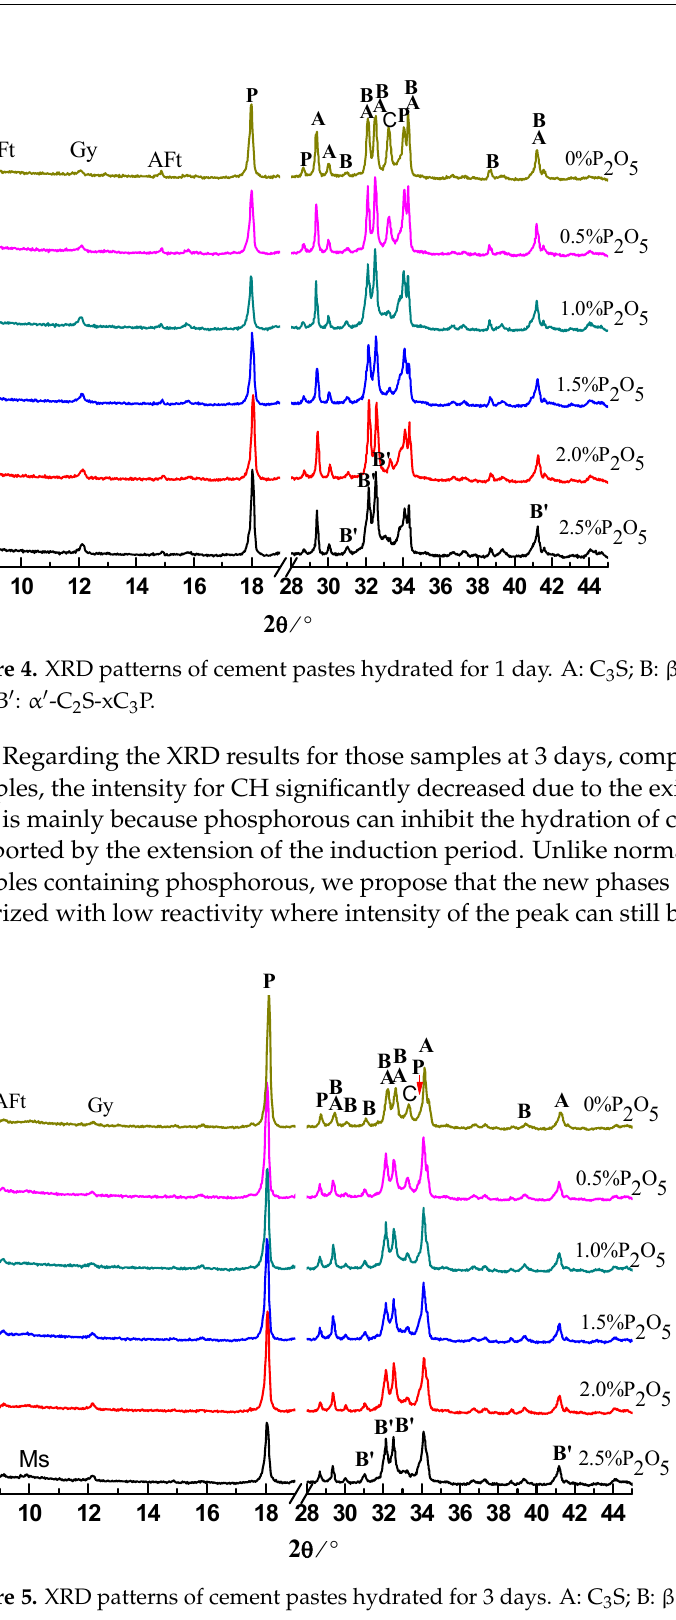
Figure 5. XRD patterns of cement pastes hydrated for 3 days. A: C 3 S; B: β -C 2 S; P: CH; Ms: AFm; B ′ : α′ -C 2 S-0.05C 3 P.